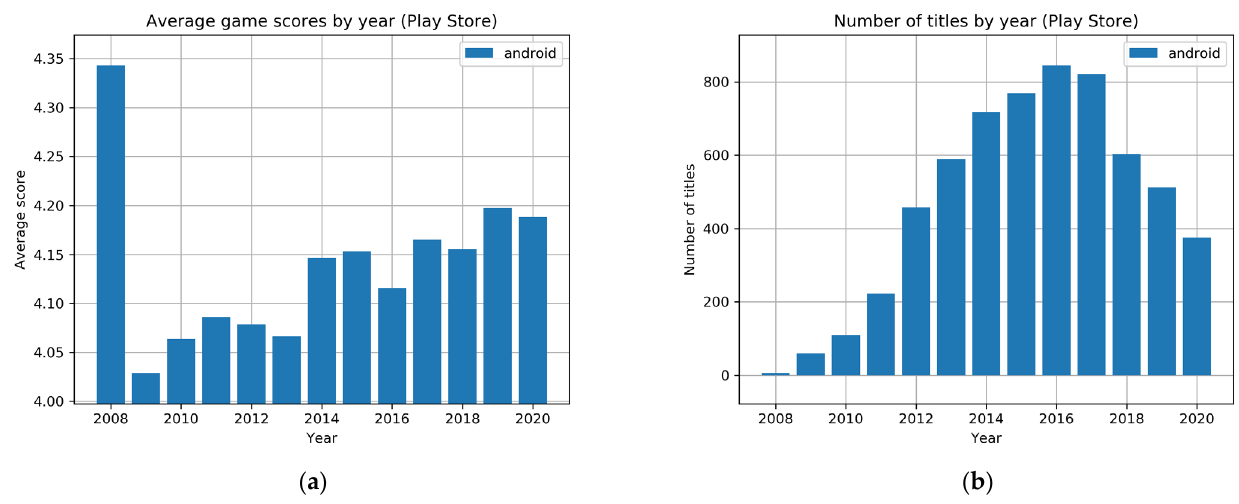
Figure 5. Evaluation of mobile games statistics over time; ( a ) average user rating by year; ( b ) number of titles by year.